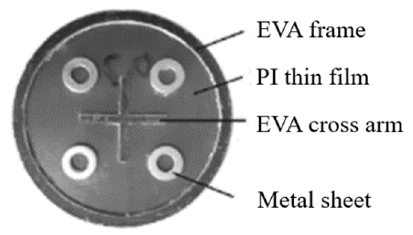
Figure 13. A small size MAM experimental sample [50].